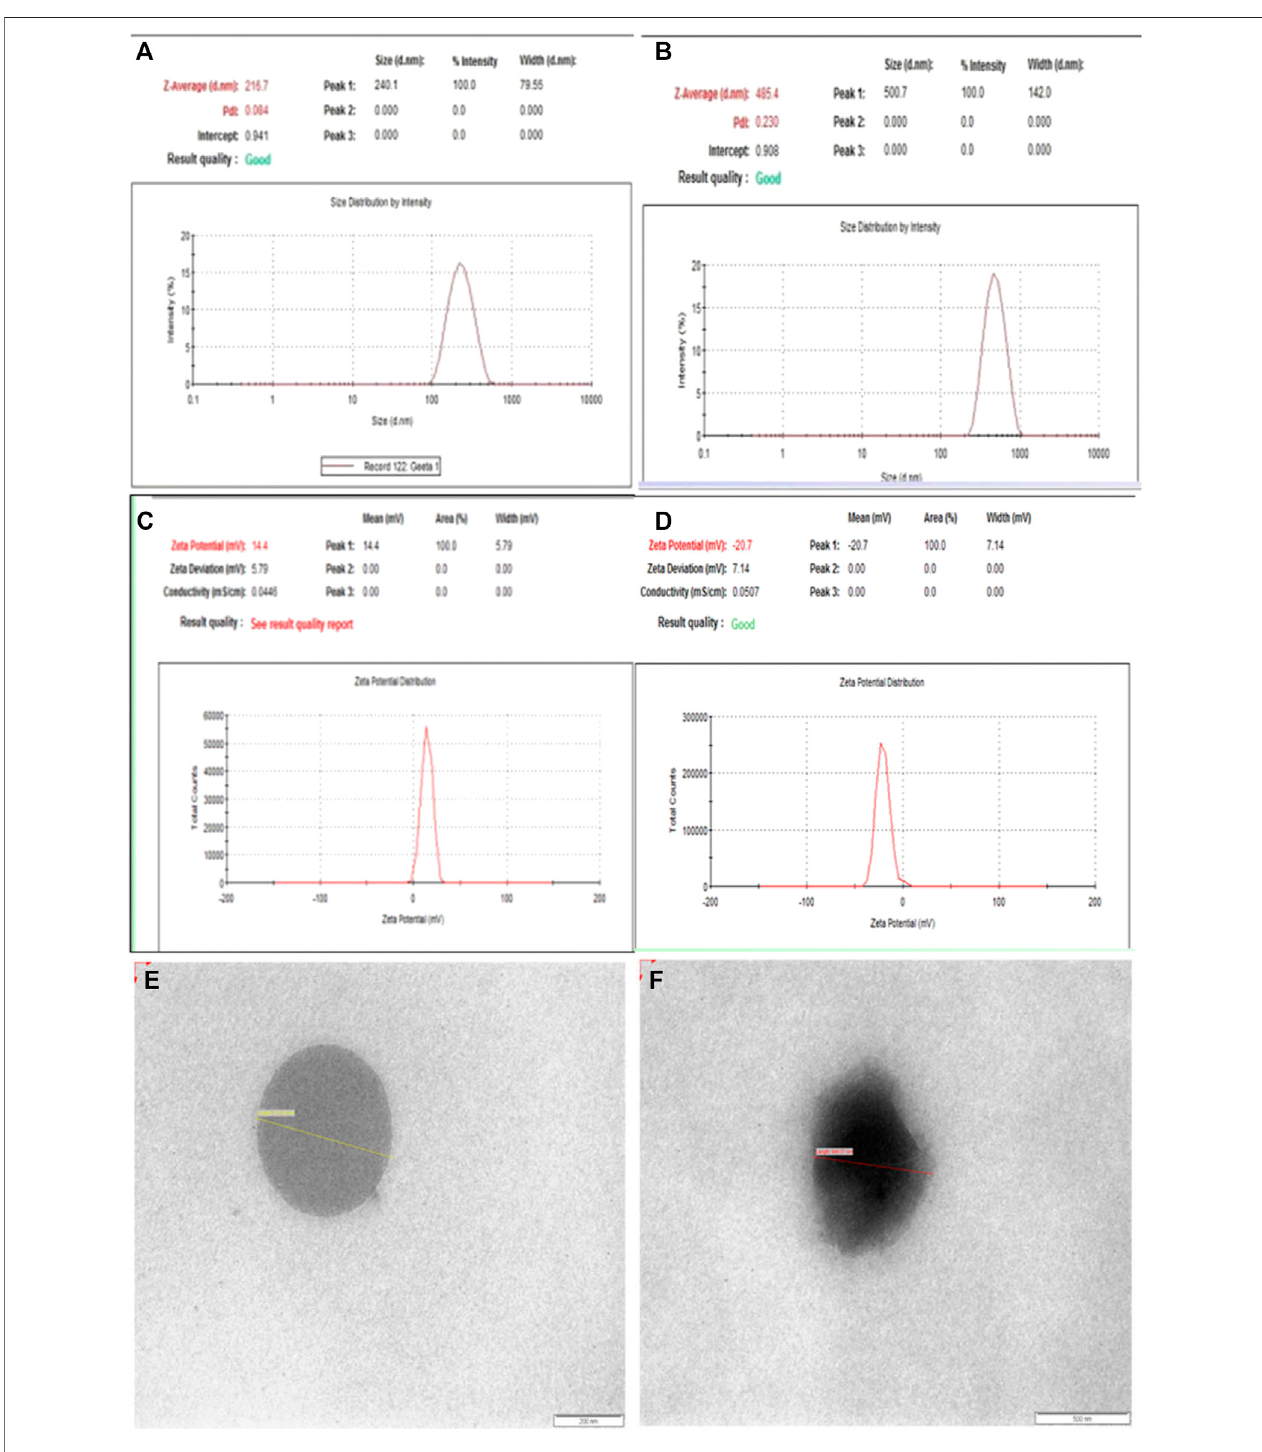
FIGURE 2 | Size (A,B) , zeta potential (C,D) and TEM images (E,F) of D-SLN and SMD-SLN.